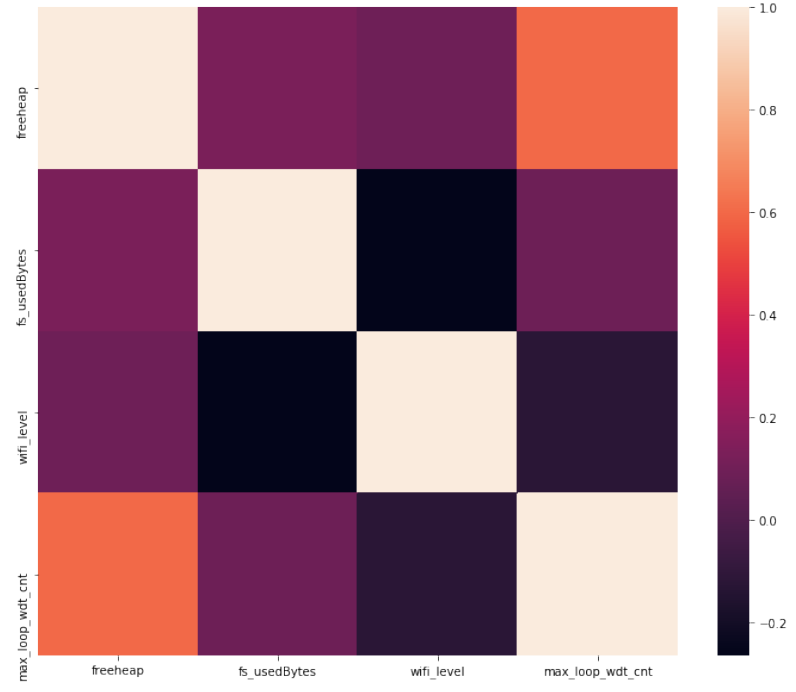
Figure 17. Smart home metrics correlation